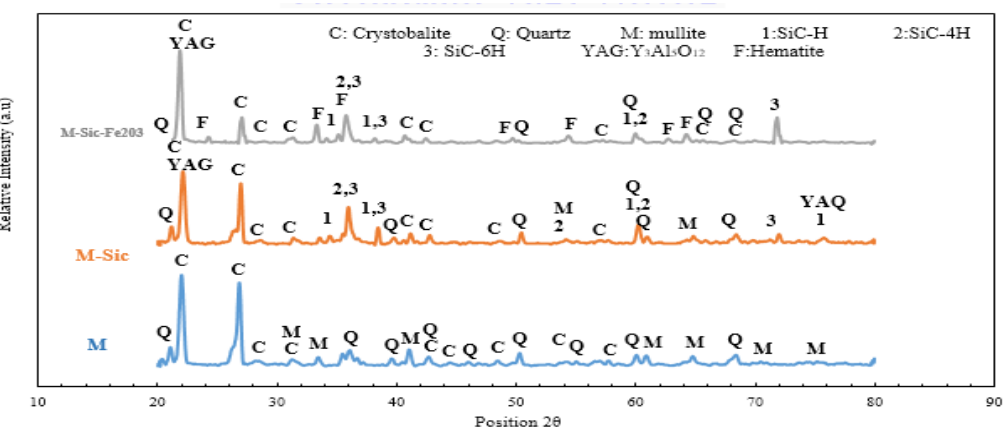
Figure 7. XRD patterns of the samples M, M/SiC and M/SiC/Fe20.